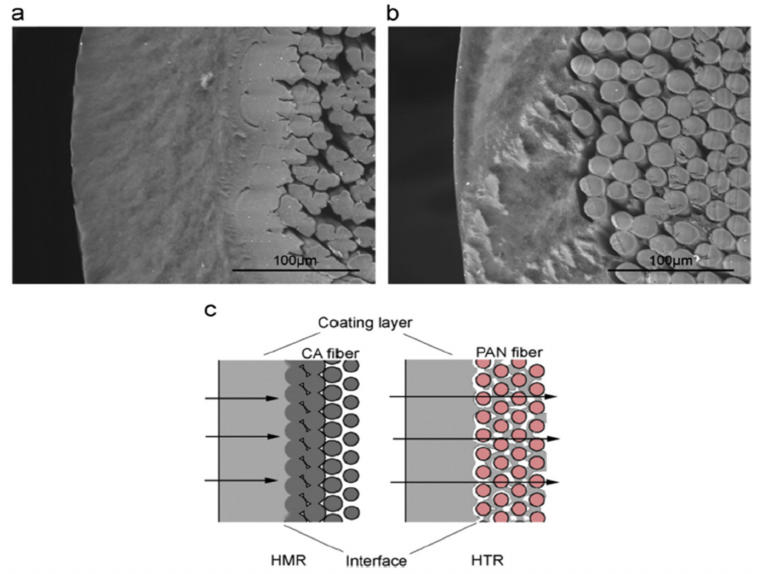
Figure 16. Comparison between interfaces of homogenous and heterogeneous braids: ( a ) HMR inter- face; ( b ) HTR interface; ( c ) Schematic representation of homogenous and heterogeneous reinforced interface [230]. Reprinted/adapted with permission from Ref. [230]. Copyright 2022,